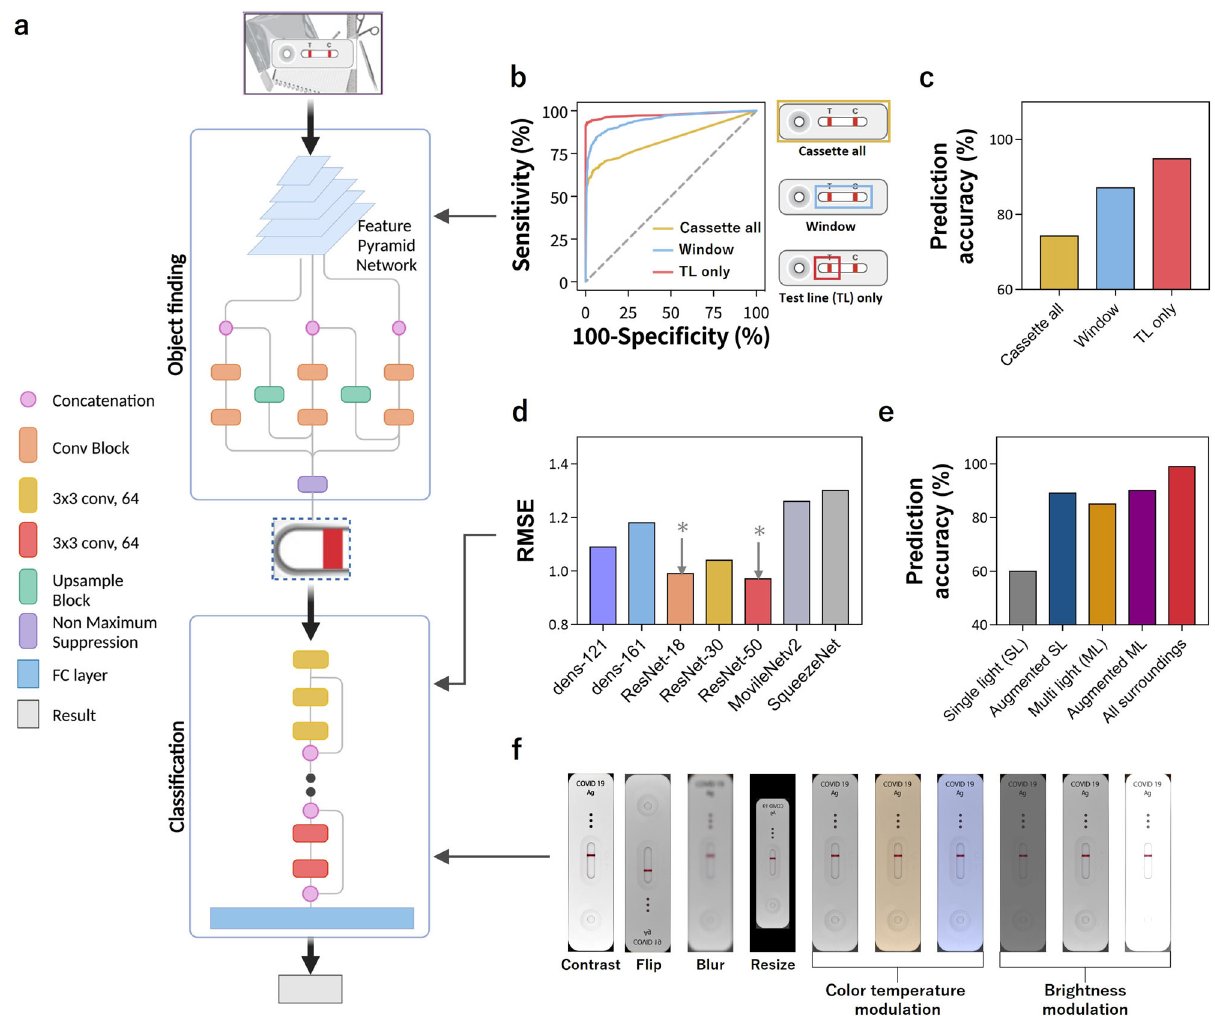
Fig. 2 | Algorithm optimization. a The algorithm of SMART AI -LFA consists of object fi ndings and classi fi cation. b , c Algorithm #1: Object fi nding; b ROC curves, and c prediction accuracy of object fi ndings using three different